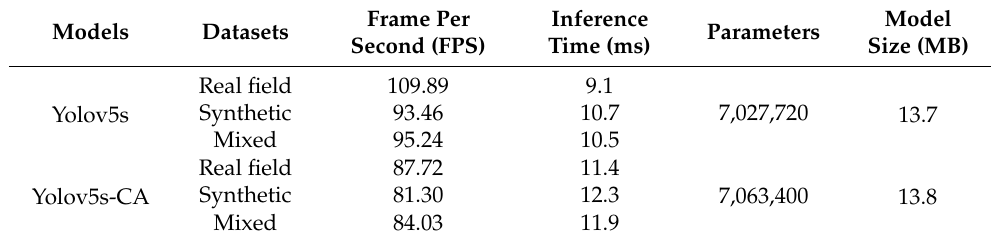
Table 4. Performance comparison of model detection